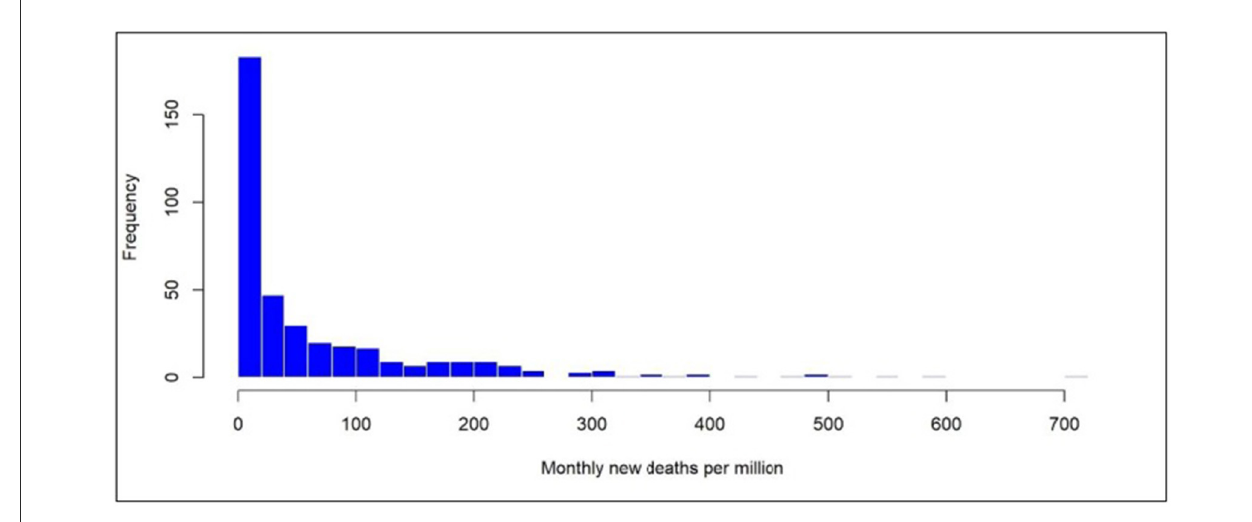
FIGURE4 Histogram of the monthly new deaths per million.